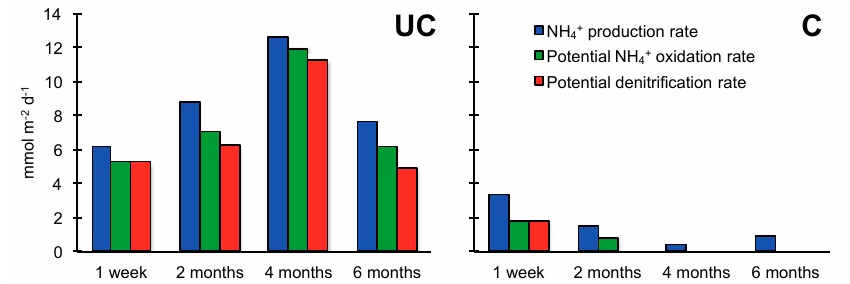
Figure 5. Area specific ammonium (NH 4+ ) production rate, potential NH 4+ oxidation and potential denitrification rates in uncultivated (UC) and cultivated (C) soil at the four sampling time points. 3.3. Abundances of the Bacterial 16S rRNA, nirS, nirK and amoA Genes The copy numbers of bacterial 16S rRNA genes, used as a proxy for bacterial abundance, ranged between 1.0 × 10 10 –6.4 × 10 10 and 6.5 × 10 9 –2.3 × 10 10 copies/g dry soil at station UC and C, respectively, which after four months had decreased to 8.2 × 10 8 –7.1 × 10 9 and 7.8 × 10 8 –1.6 × 10 9 copies/g dry soil (Figure 6a). The nirS gene showed the same trend over time as the bacterial 16S rRNA gene, but occurred at lower abundances, except at station UC where the nirS gene abundances were lower before flooding (Figure 6c). The amoA gene copy numbers at station C showed only a small increase over time. On the contrary, at station UC the bacterial amoA gene copy numbers increased significantly from zero to 5.7 × 10 5 copies/g dry soil at 0–1 cm depth after four months, and archaeal amoA that increased from 6.7 × 10 4 to 3.2 × 10 5 copies/g dry soil after six months (Figure 6d,e). Furthermore, copy numbers of the nirK gene increased in similar fashion, reaching up to 1.7 × 10 7 and 9.4 × 10 6 copies/g dry soil at station UC and C, respectively, after four months (Figure 6b).